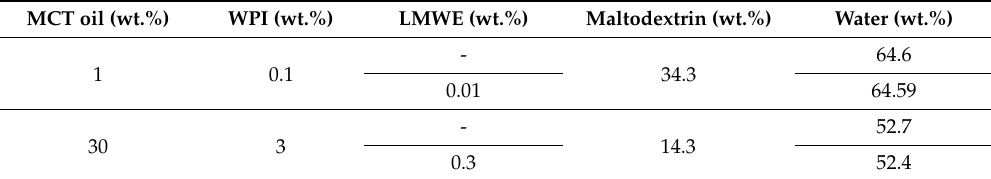
Table 1. Summary of the composition of emulsions for atomization experiments. All reported values refer to the total emulsion. MCT = medium-chain triglycerides; WPI = whey protein isolate; LMWE = low molecular weight emulsifier. MCT oil